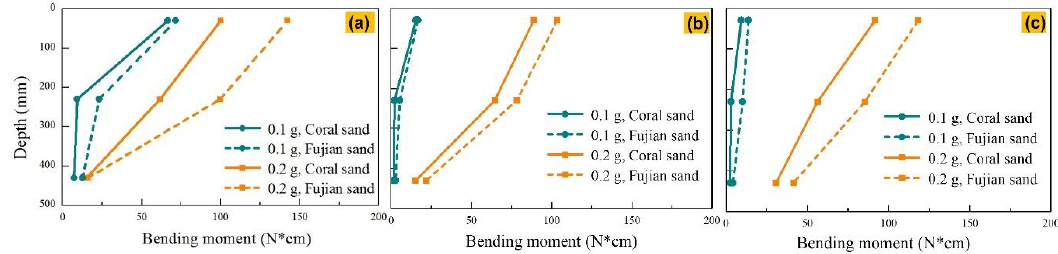
Figure 15. Peak pile bending moments at different depth: ( a ) corner pile; ( b ) edge pile; and ( c ) center pile.